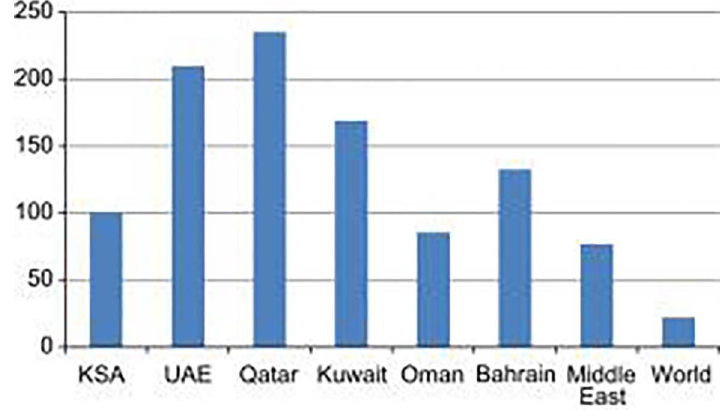
Figure 1. Annual per capita electricity consumption in MWh (Source: Asif,